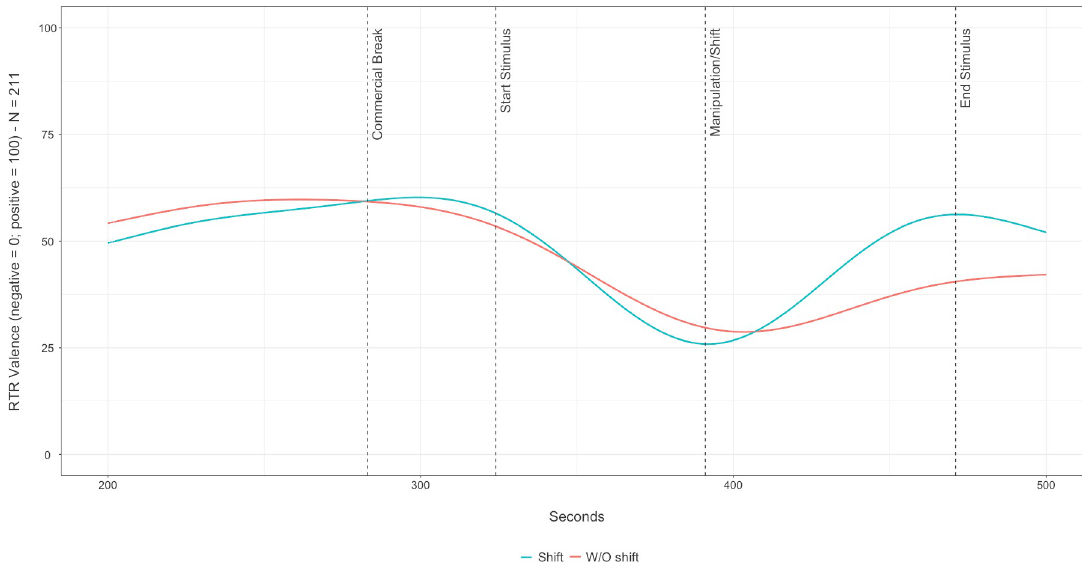
Fig 2. Subjective indication of valence (Pleasant/unpleasant) of the two Stimuli